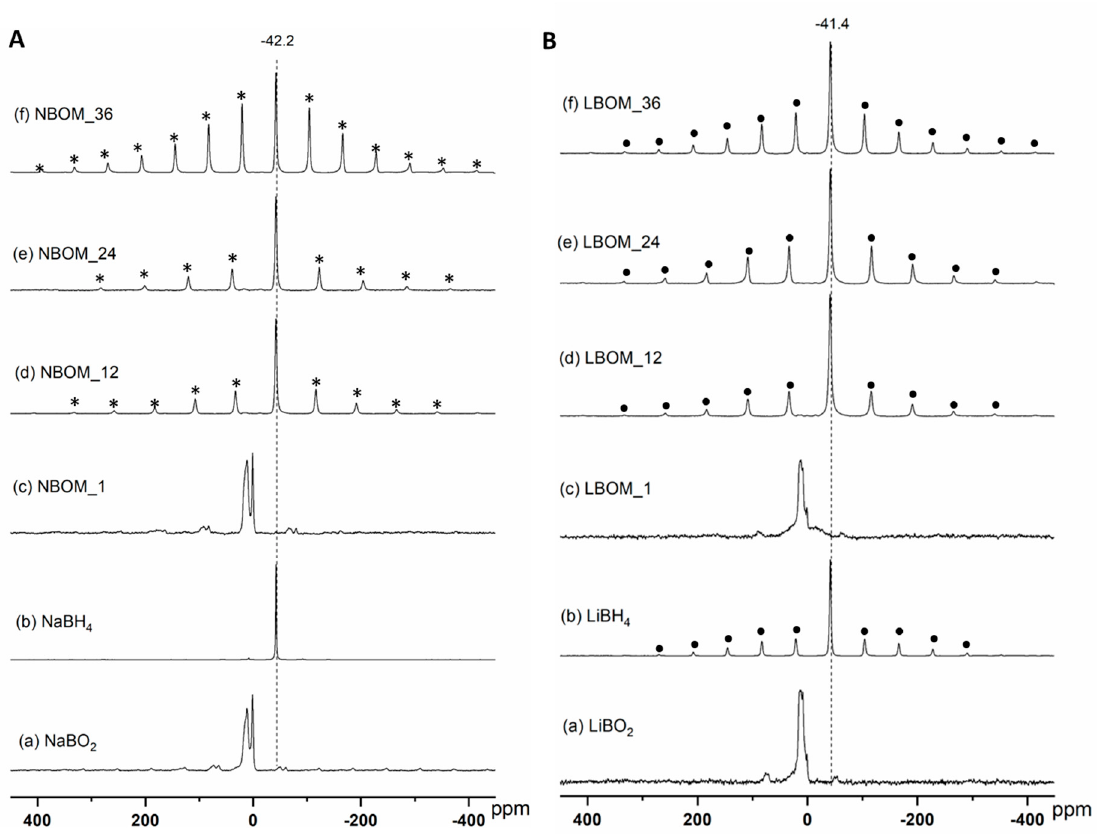
Figure 5. 11 B MAS-NMR spectra of materials: ( A ) (a) NaBO 2 , (b) NaBH 4 , (c) NBOM_1, (d) NBOM_12, (e) NBOM_24 and (f) NBOM_36; ( B ) (a) LiBO 2 , (b) LiBH 4 , (c) LBOM_1, (d) LBOM_12, (e) LBOM_24, and (f) LBOM_36. Spinning sideband resonances from NaBH 4 and LiBH 4 are indicated by asterisks ( ∗ ) and solid circles ( ● ), respectively.